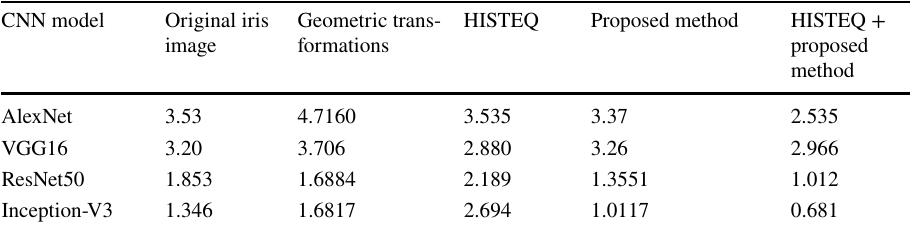
Table 3 EER of classification experiment(%)